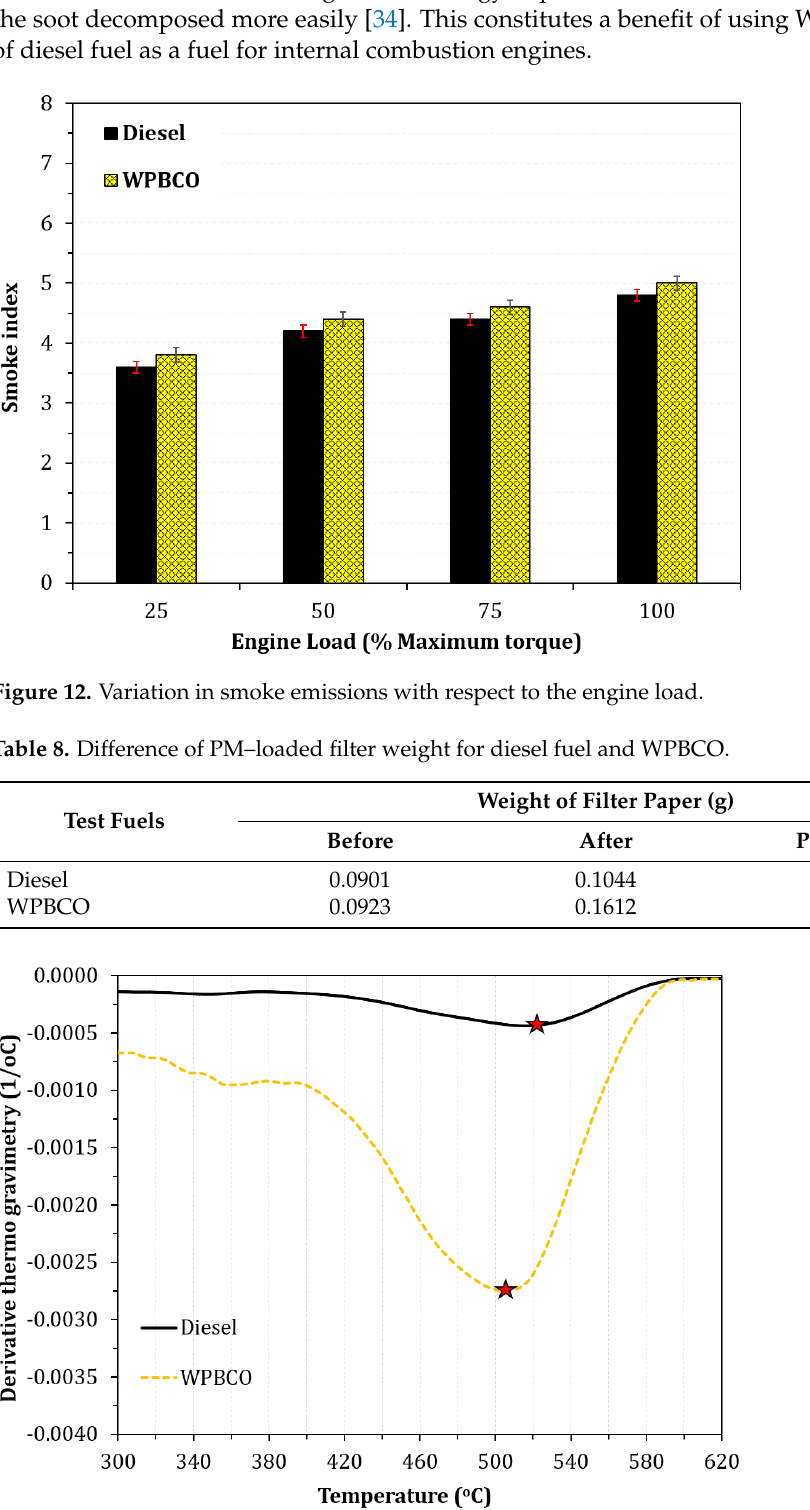
Figure 12. Variation in smoke emissions with respect to the engine load.